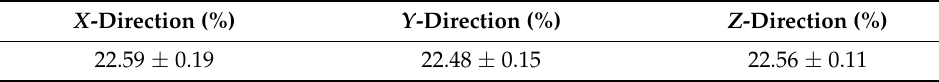
Table 2. Sintering shrinkage in all